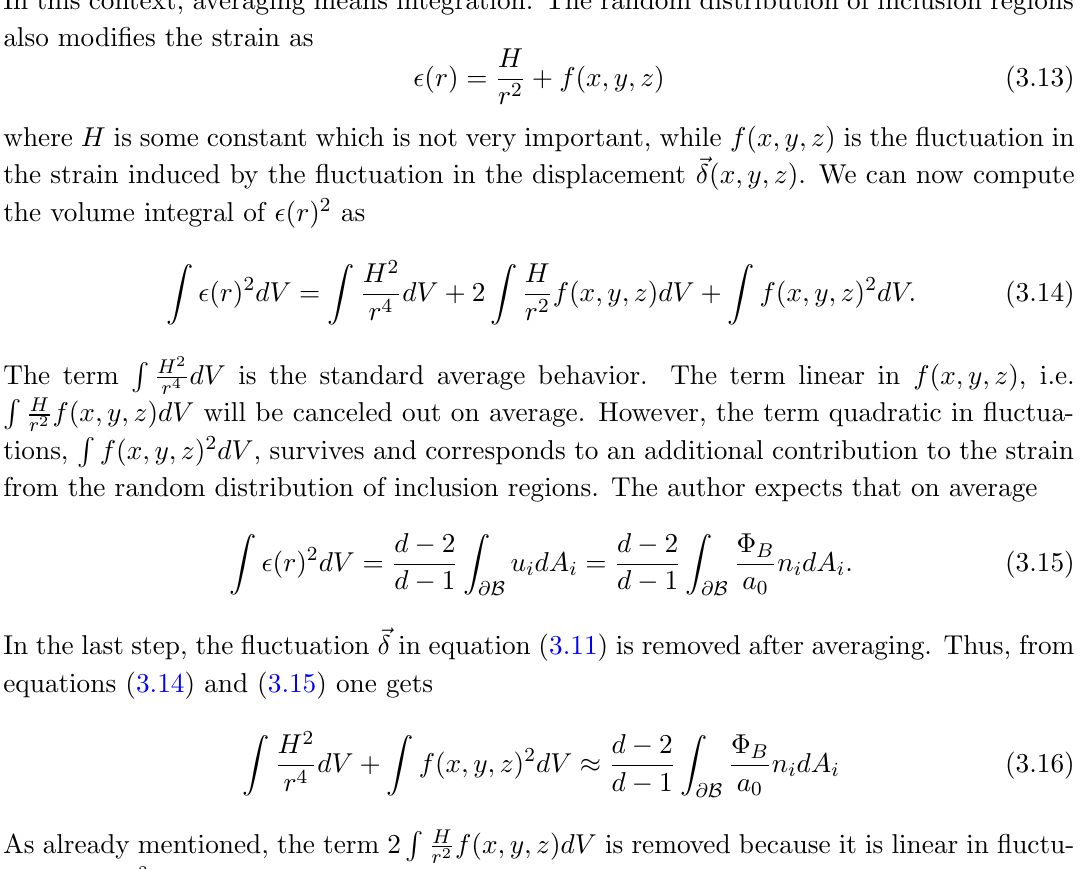
=V 0 . Outside of these 0